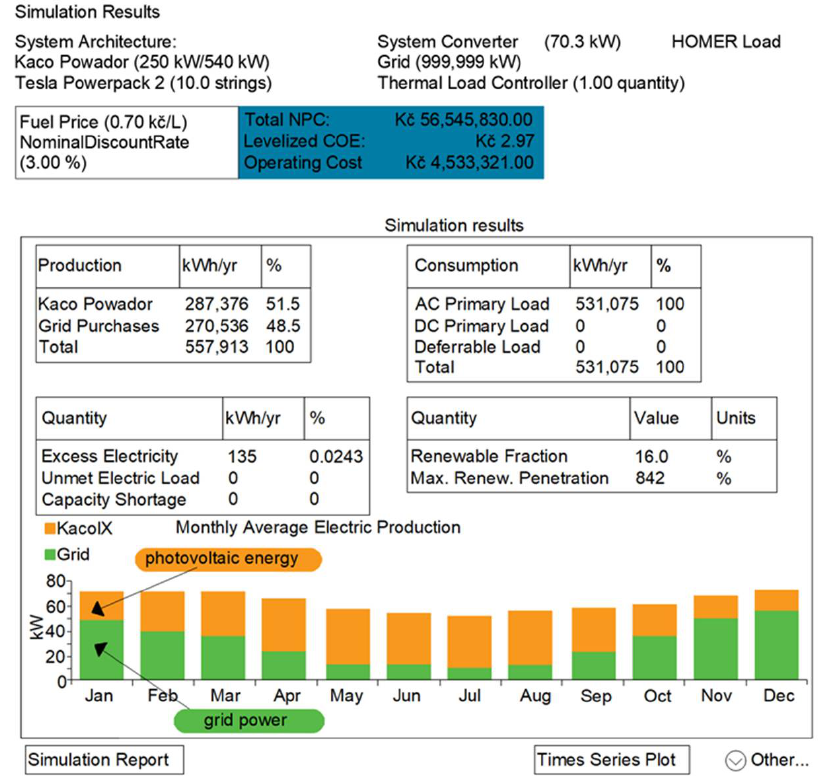
Figure 21. Resulting simulation of energy produced by RES and energy delivered from the grid. Other tabs provide an overview of the renewable energy production at the given hour of the day (Figure 22).